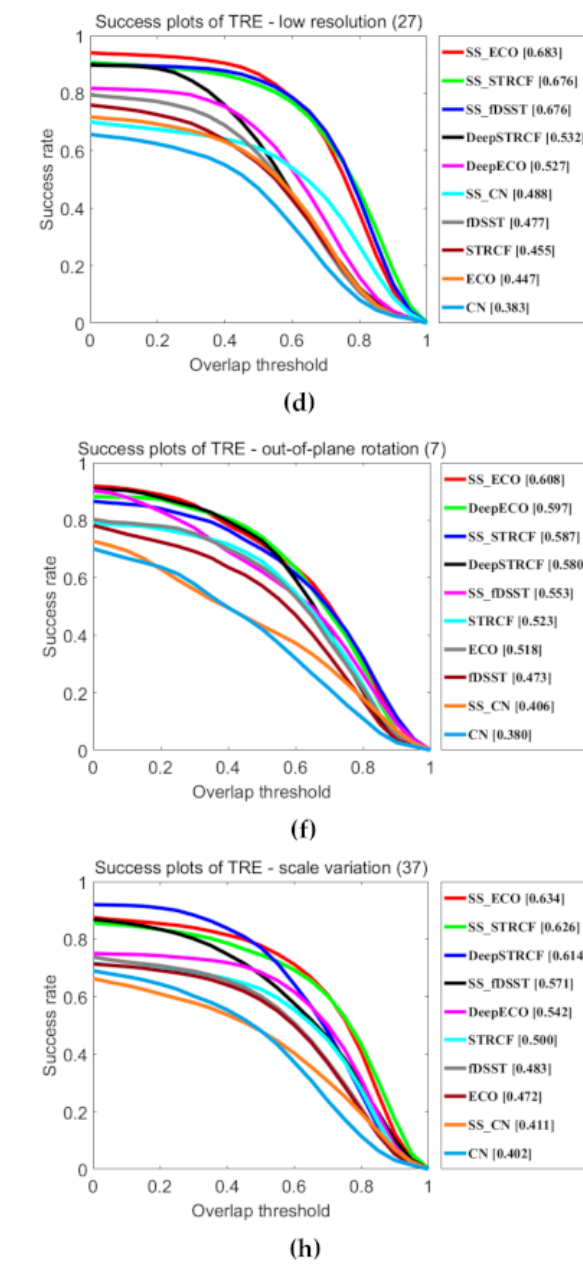
Figure 14. Success plots over eight tracking attributes, including ( a ) background clutter (24), ( b ) deformation (18), ( c ) illumi- nation variation (20), ( d ) low resolution (27), ( e ) occlusion (36), ( f ) out-of-plane rotation (7), ( g ) out of view (4), ( h ) scale variation (37). The values in parentheses indicate the number of sequences associated with each attribute. The legend reports the area-under-the-curve